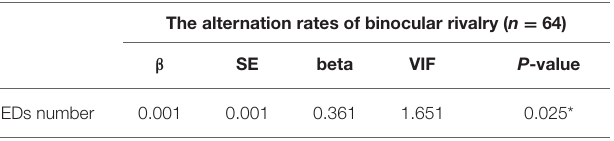
TABLE 6 | Forward stepwise linear regression showing factors independently associated with rivalry rate in patients with IEDs. The alternation rates of binocular rivalry ( n =